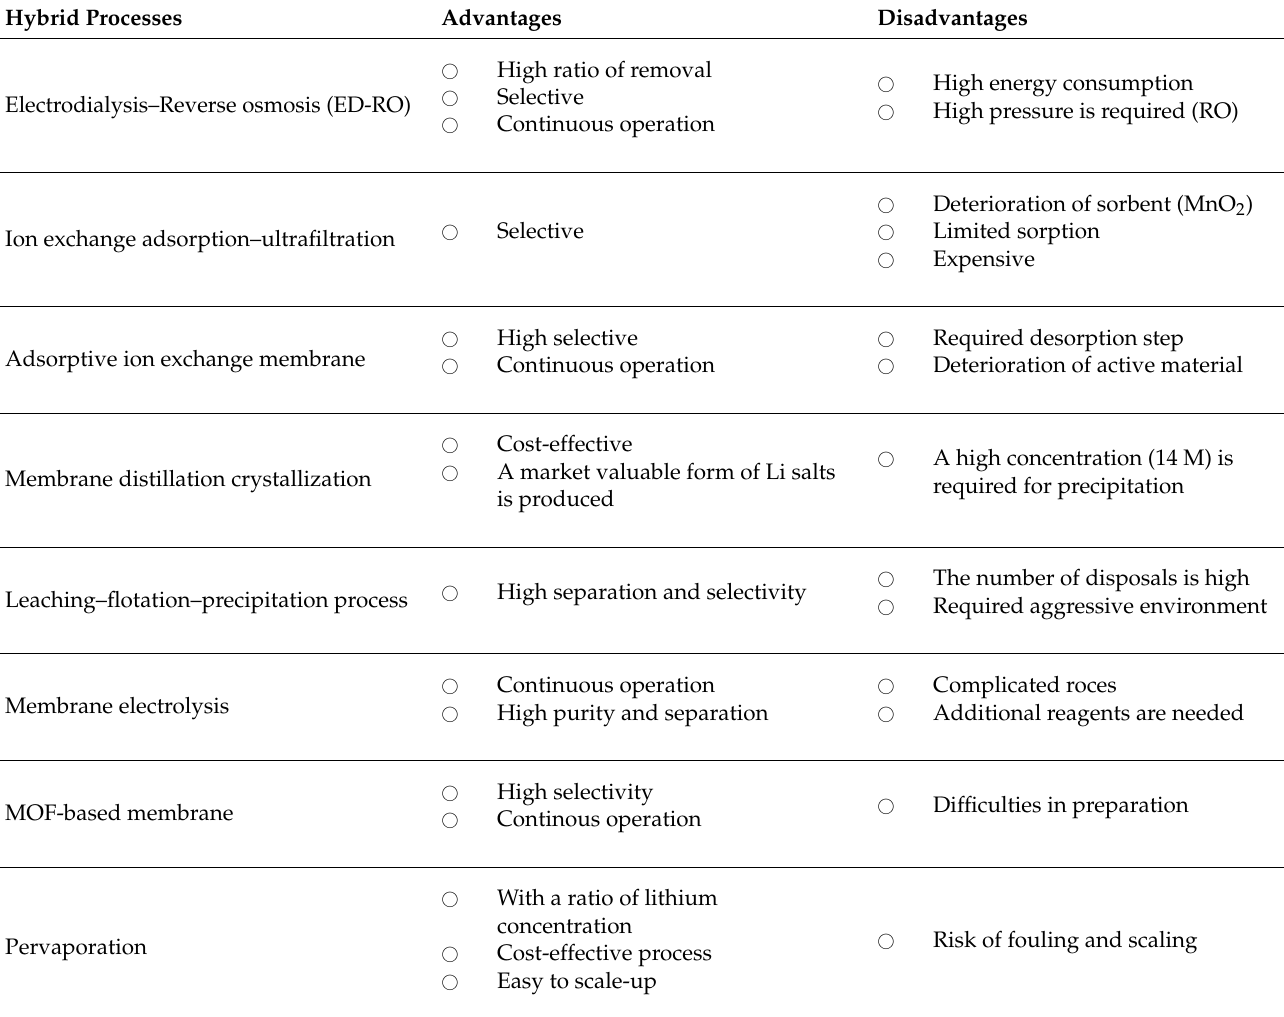
Table 9. Comparison of the hybrid process of lithium